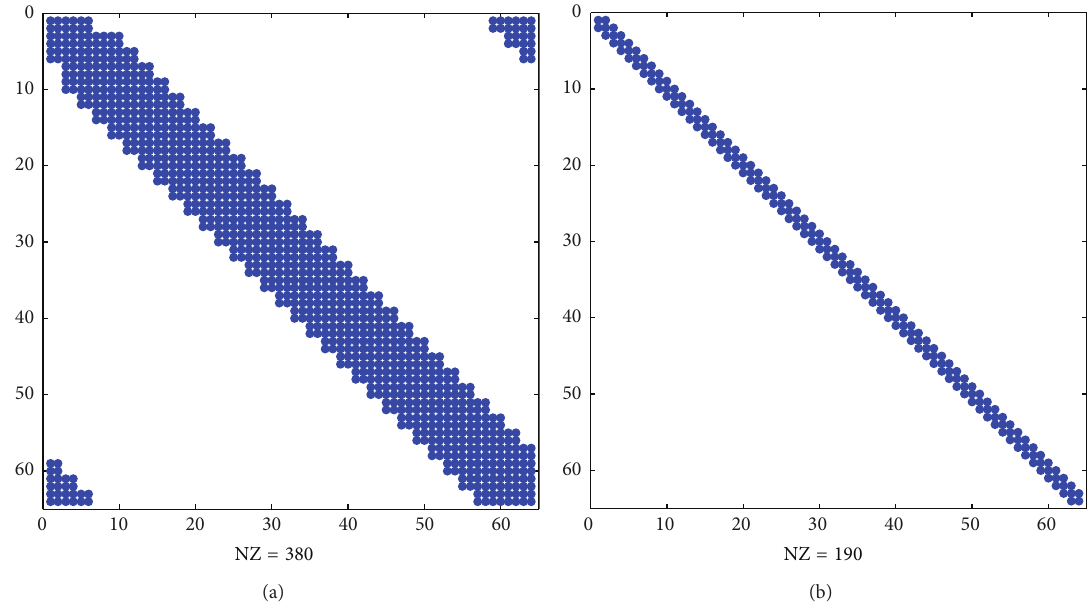
Figure 2: (a): Sparsity pattern of the derivative matrix 𝐷 matrix of the cubic spline wavelet, where 𝐷